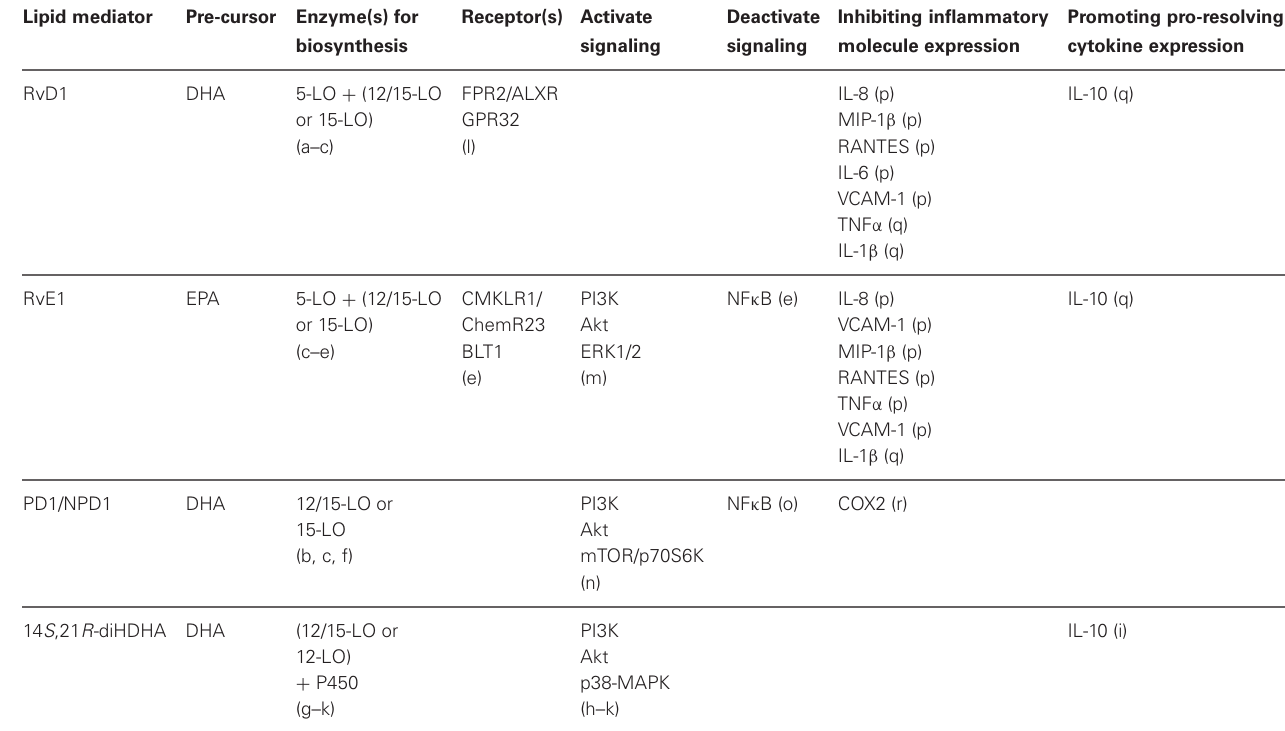
Table 1 | Selected characteristics of n3-PUFAs-derived lipid mediators. Lipid